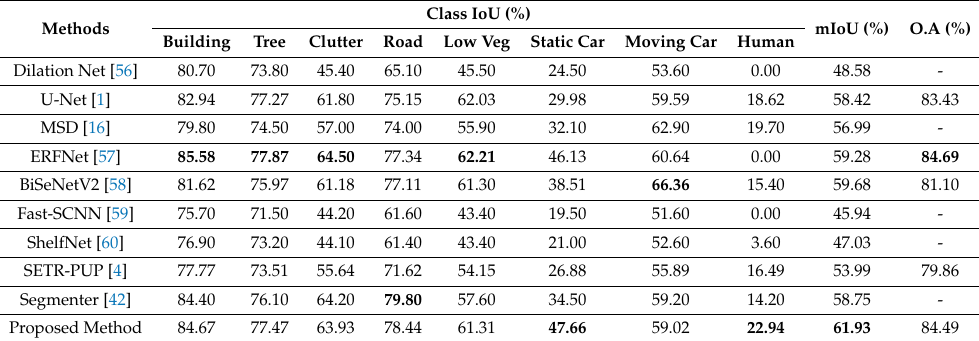
Table 1. Quantitative comparison of the UAVid test dataset result with competitive methods.